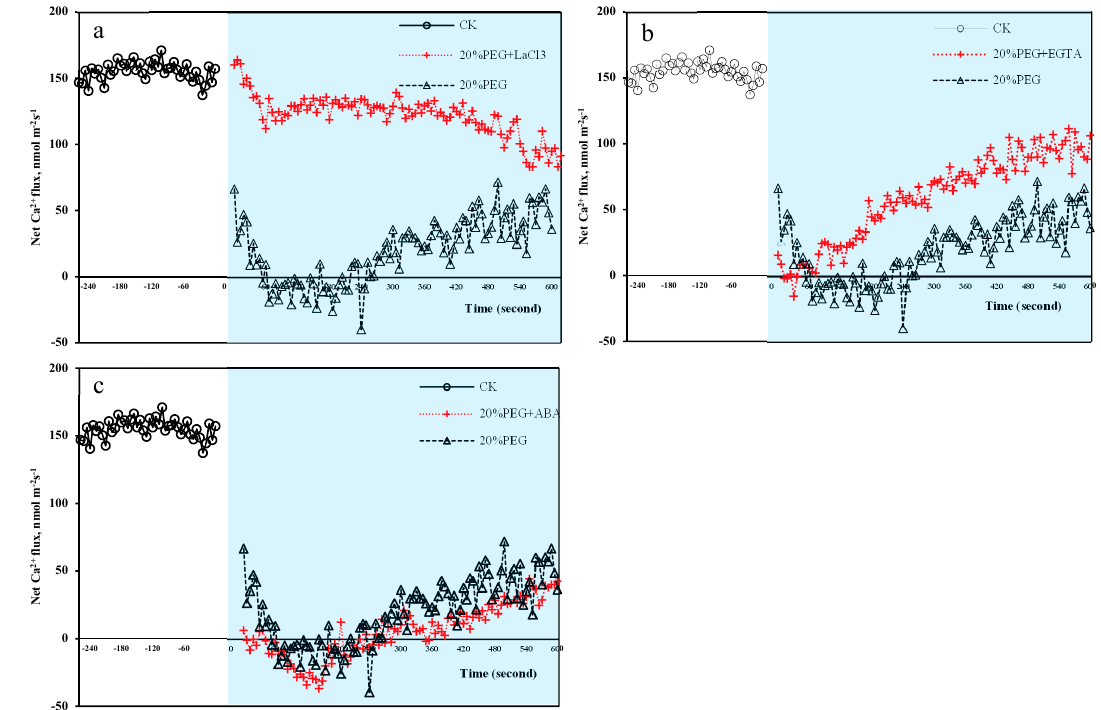
Figure 6. Factor analysis of Ca 2+ flux of P. edulis seedlings under drought stress (Data Repetition: 3 replicates). The white area represents Ca 2+ oscillation in the pileorhiza after treatment of the P. edulis seedlings with distilled water (CK), and the black line graph in the blue area indicates the Ca 2+ oscillation in the pileorhiza treated with 20% PEG-induced drought stress for 10 minutes. The red line in the blue region indicates Ca 2+ oscillation under 0.5 mmol/L LaCl 3 ( a ), 3 mmol/L EGTA ( b ), and 30 μ mol/L ABA ( c ) in the 20% PEG treatment for 10 minutes.